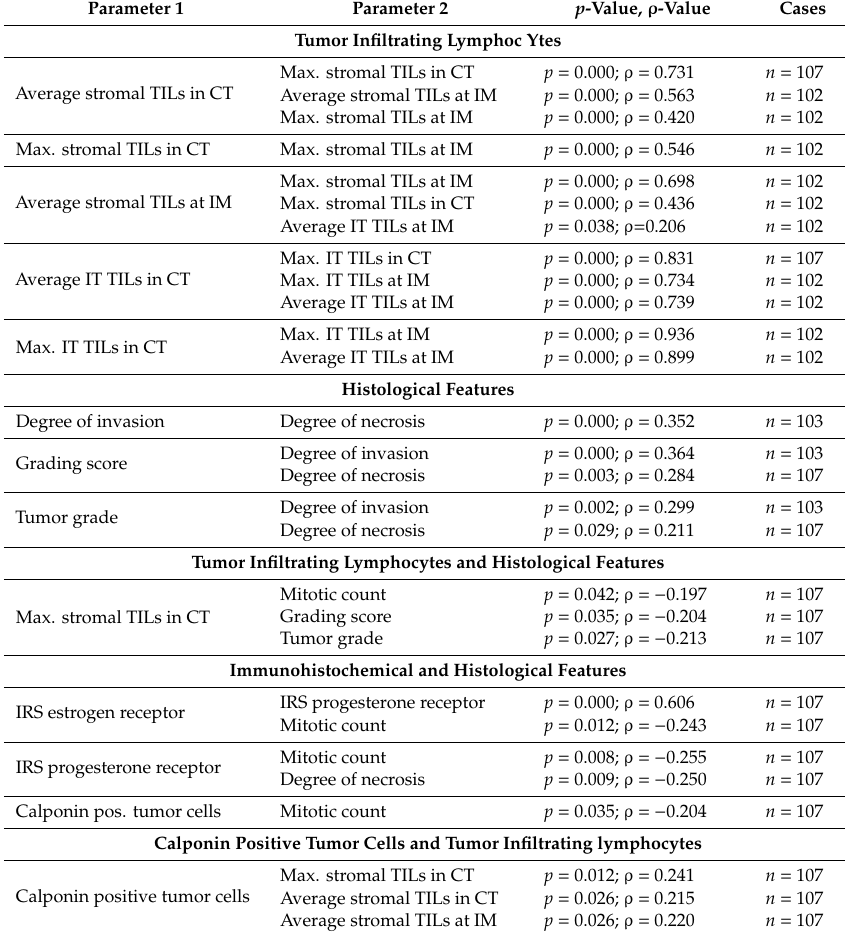
Table 3. Results of statistical